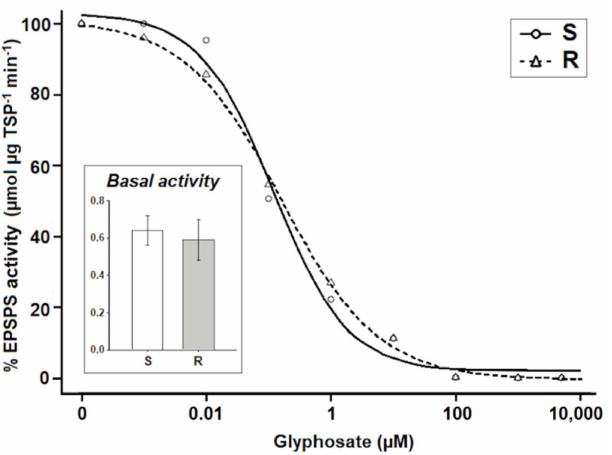
Figure 3. Enzyme activity of the 5-enolpyruvilshikimate-3-phosphate synthase (EPSPS) in glyphosate- susceptible (S) and -resistant (R) saltmarsh aster ( A. squamatus )